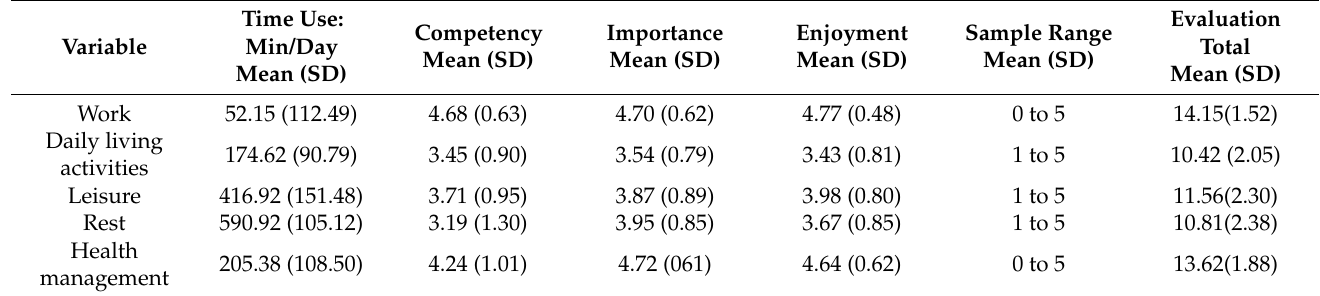
Table 2. Subjective evaluation of time management ( N = 195).